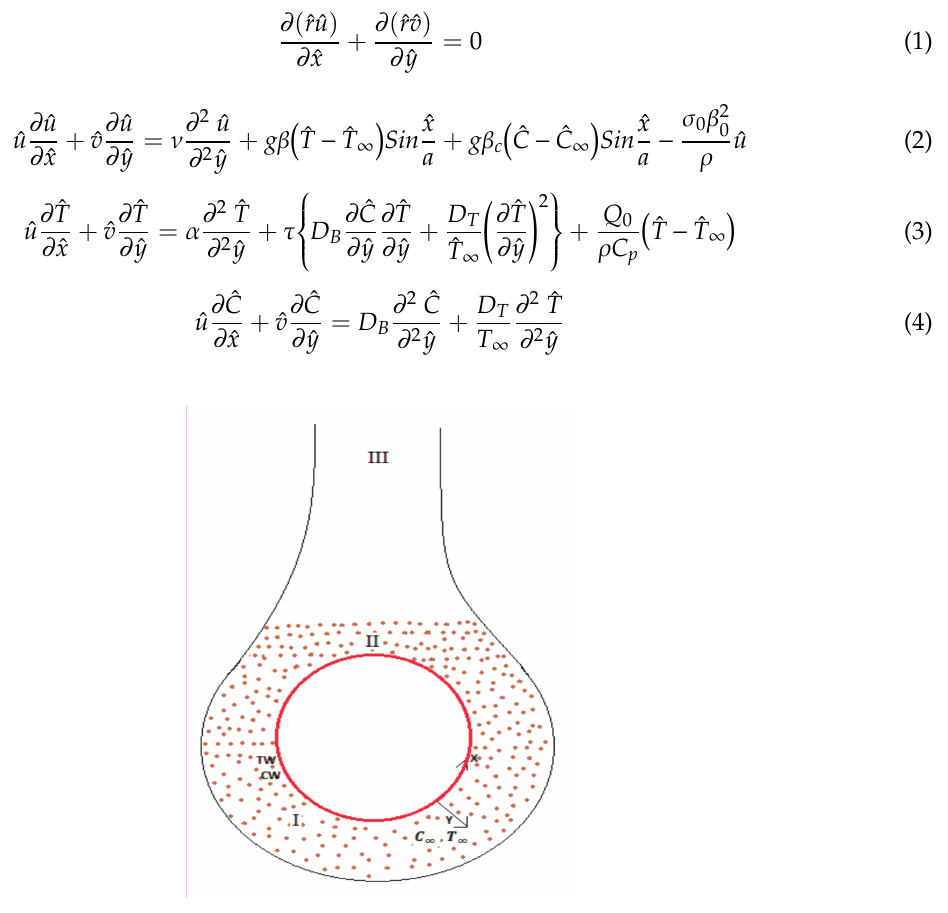
Figure 1. Coordinate System and Flow